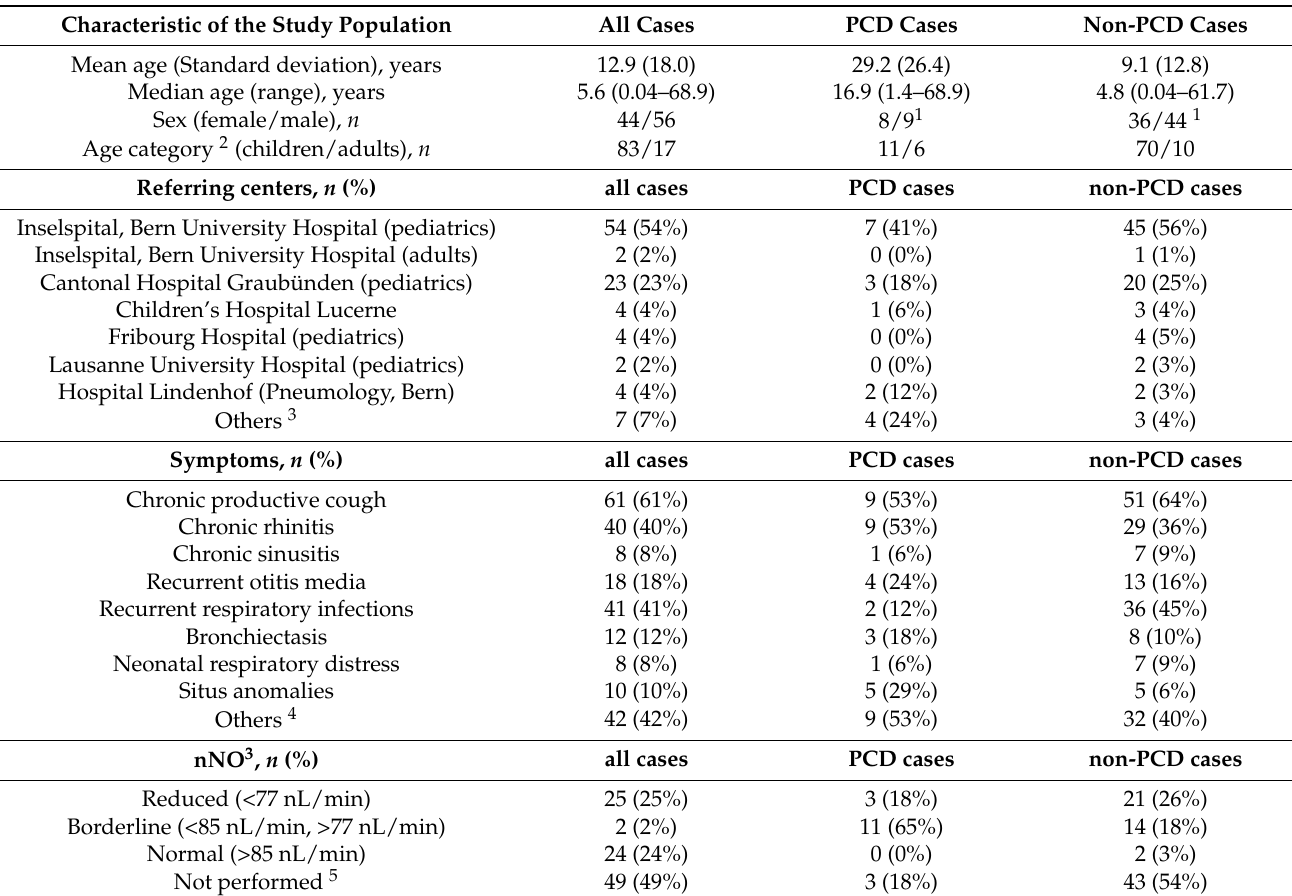
Table 1. Characteristics of the study population, summary of the referring centers, and overview of the diagnostic status and outcome. Percentages are related to the total number of cases in the respective